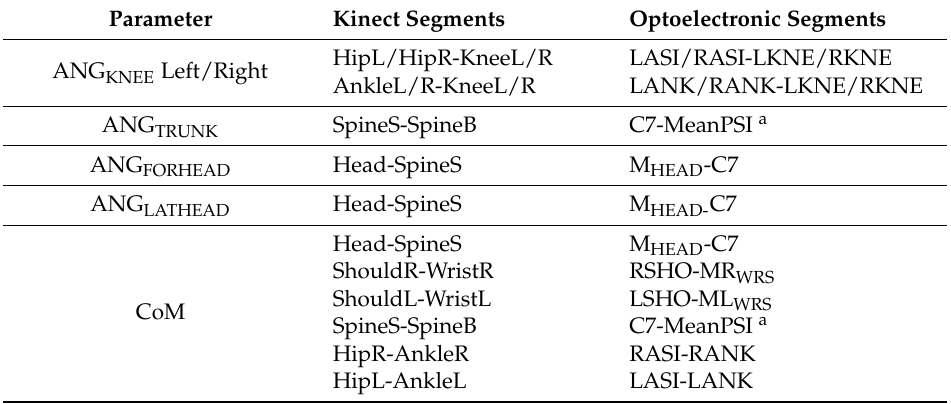
Table 2. Correspondences between body segments for Kinect and optoelectronic